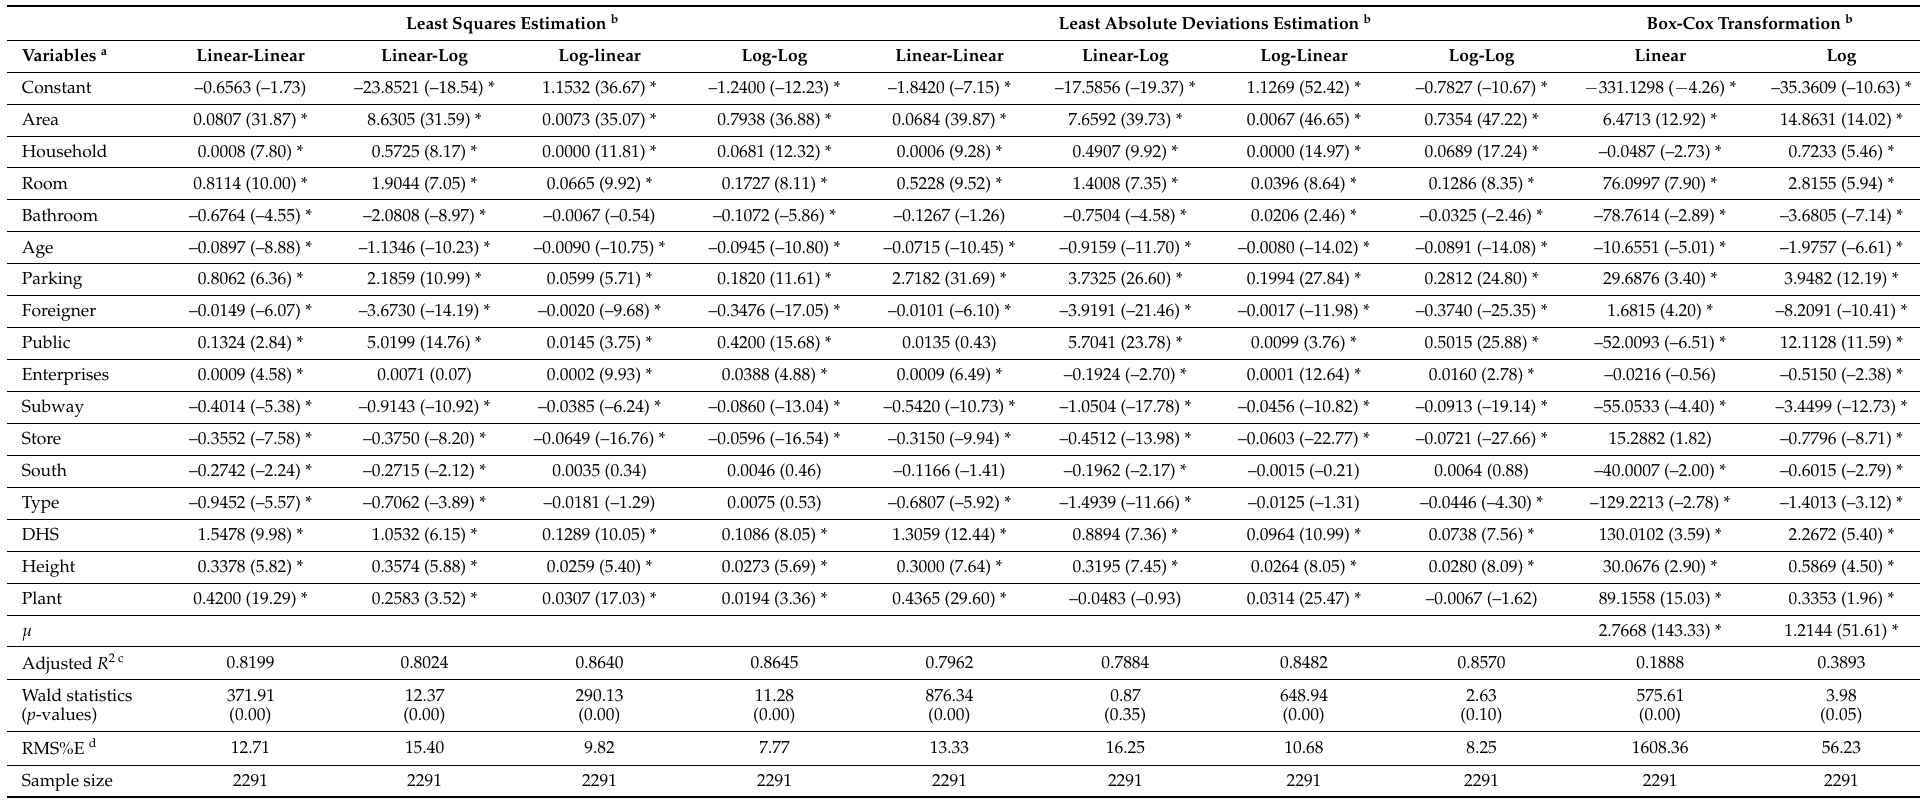
Table 2. Various housing price equations estimated in this